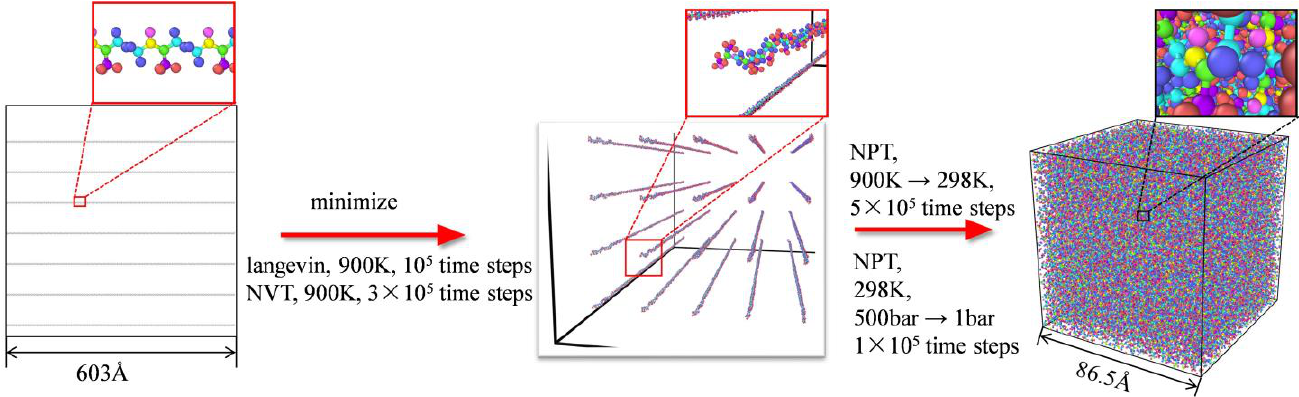
Figure 2. Molecular model of polyisoprene after equilibrating.